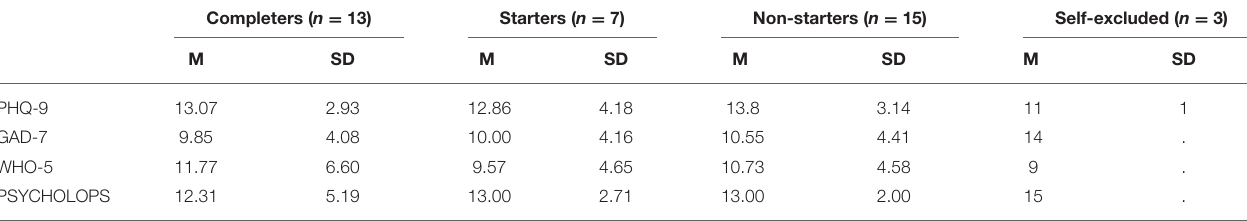
TABLE 2 | Study outcome variables at baseline ( N = 38).